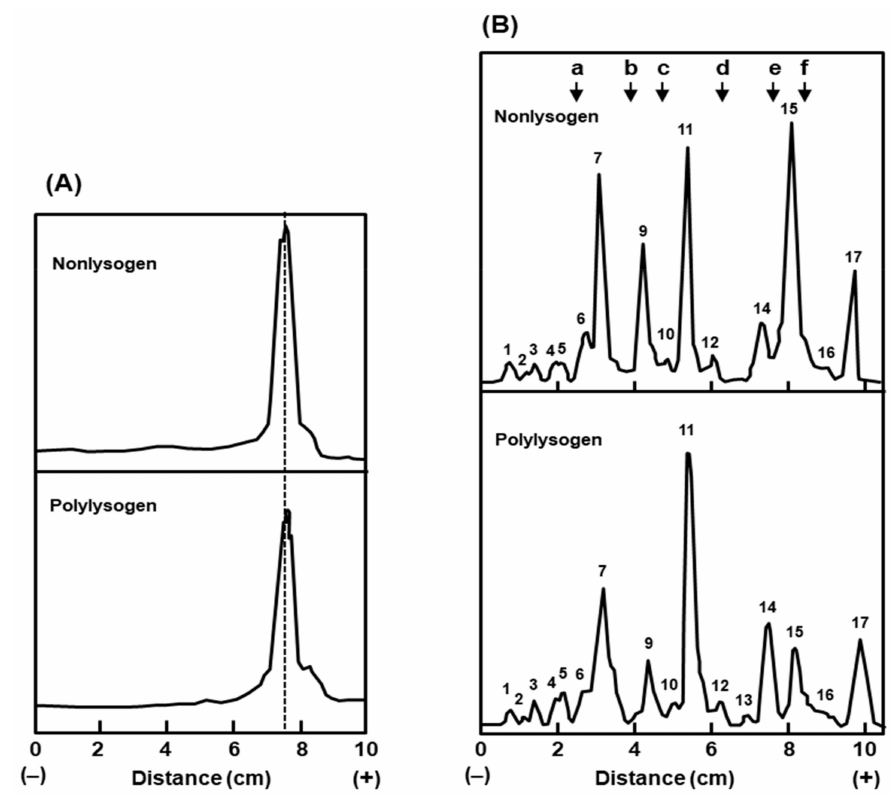
Figure 6. The LPS (A) and outer membrane proteins (B) of the polylysogen and nonlysogen were analyzed by gel electrophoresis as described in Section 4.2.3. The stained bands in the respective gels were densitometrically scanned and plotted as shown. Protein molecular weight markers (indicated in the top right panel) and their sizes were as follows: (a) bovine serum albumin, 68k; (b) ovalbumin, 45k; (c) pepsin, 34.7k; (d) trypsinogen, 24k; (e) β -lactoglobulin, 18k; (f) lysozyme, 14.3k. The major protein bands were serially numbered (1–17) by their migration distance from the